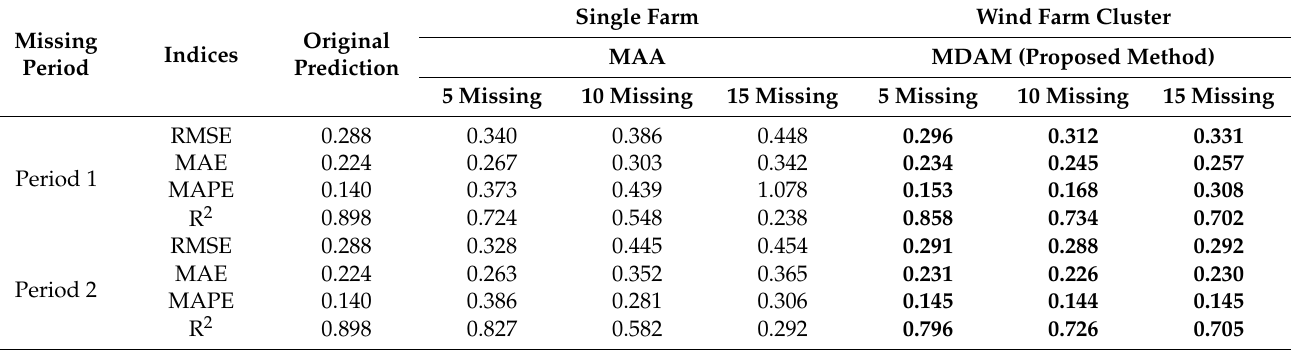
Table 7. Improvement of single-farm and wind farm cluster prediction in different conditions of missing data *.